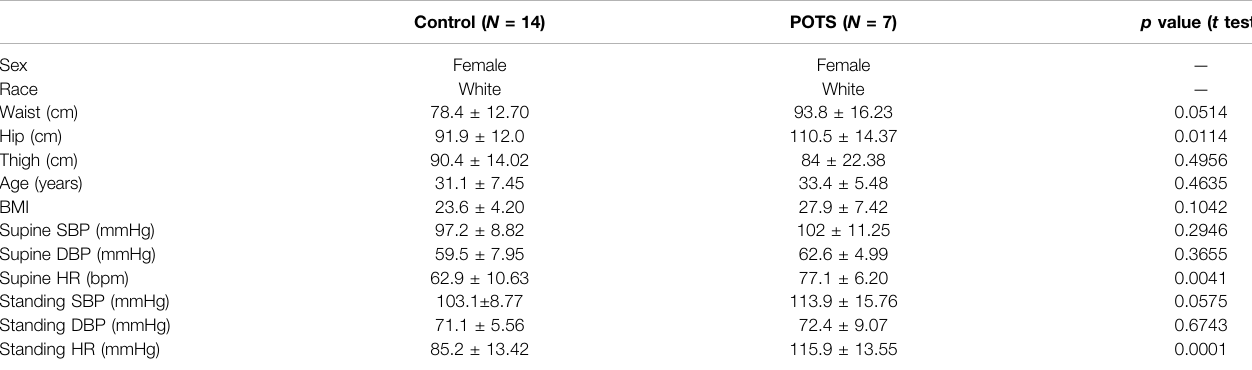
TABLE 1 | Demographic and clinical characteristics of the